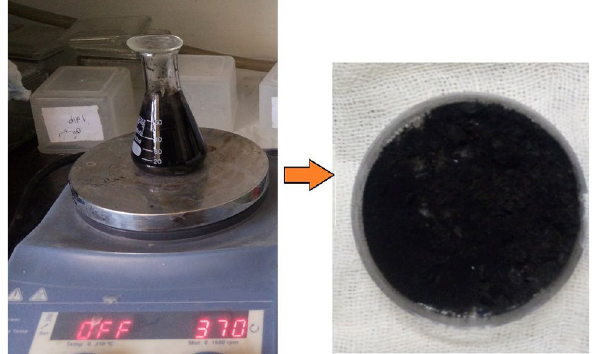
Figure 1. Representative image for synthesis of polypyrrole–alginate